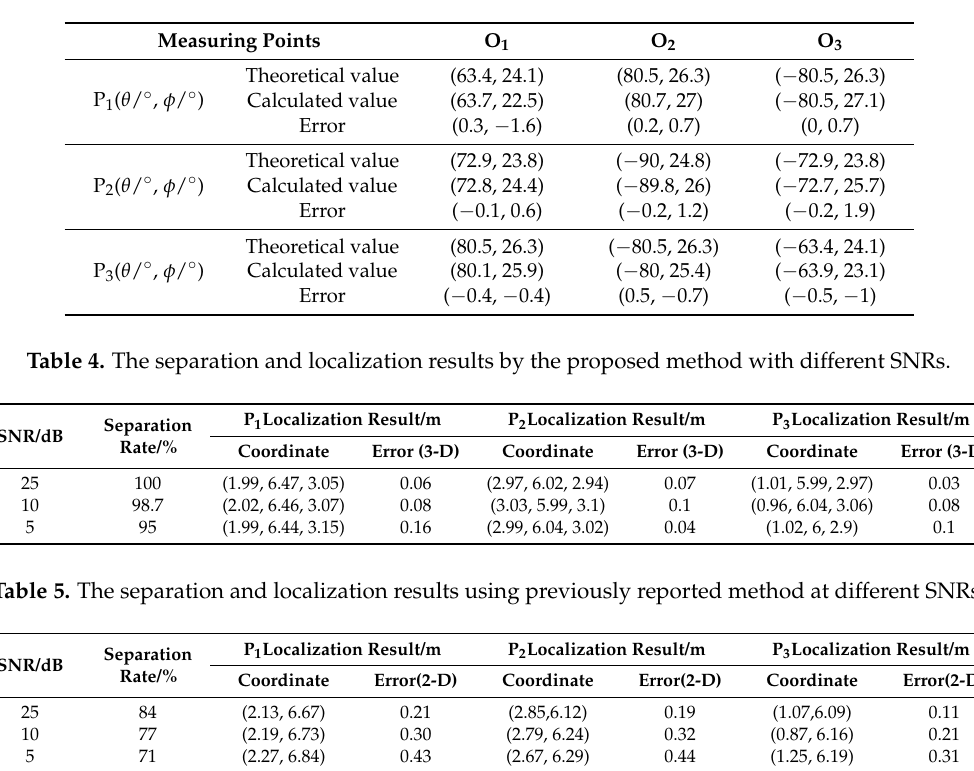
Table 3. The direction angles of the three measurement points when SNR = 5 dB.